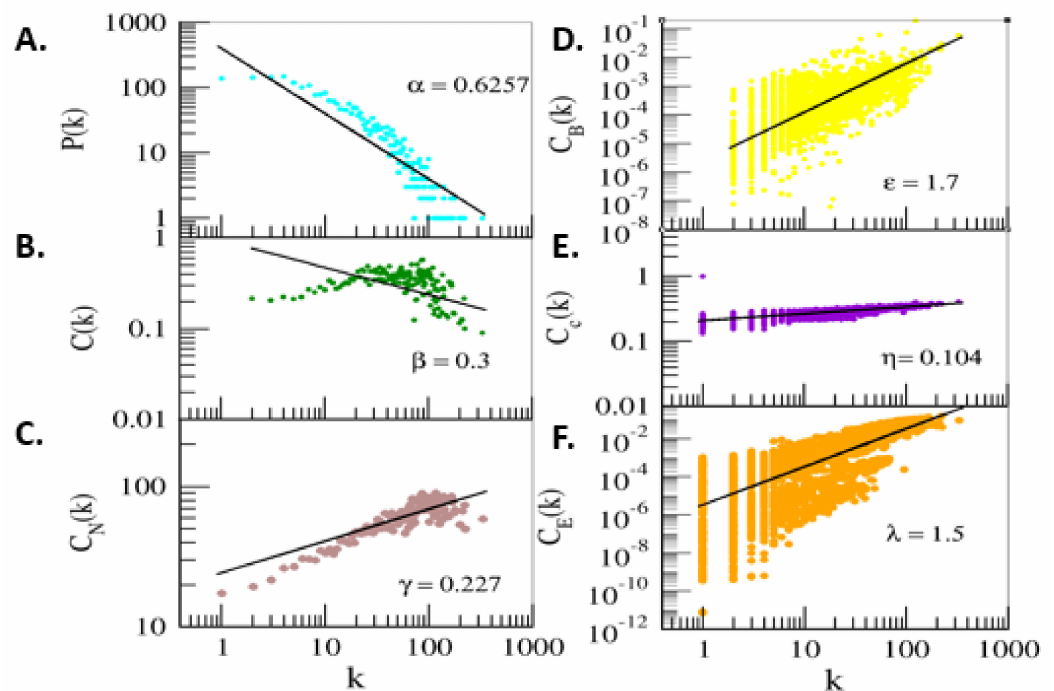
Figure 6. Topological properties of the network. ( A ) Probability of node degree distribution as function of degree k. ( B ) Clustering coefficient as function of degree k ( C ) Neighborhood connectivity as function of degree k. ( D )Betweenness centrality as function of degree k. ( E ) Closeness centrality as function of degree k. ( F ) Eigenvector value as function of degree